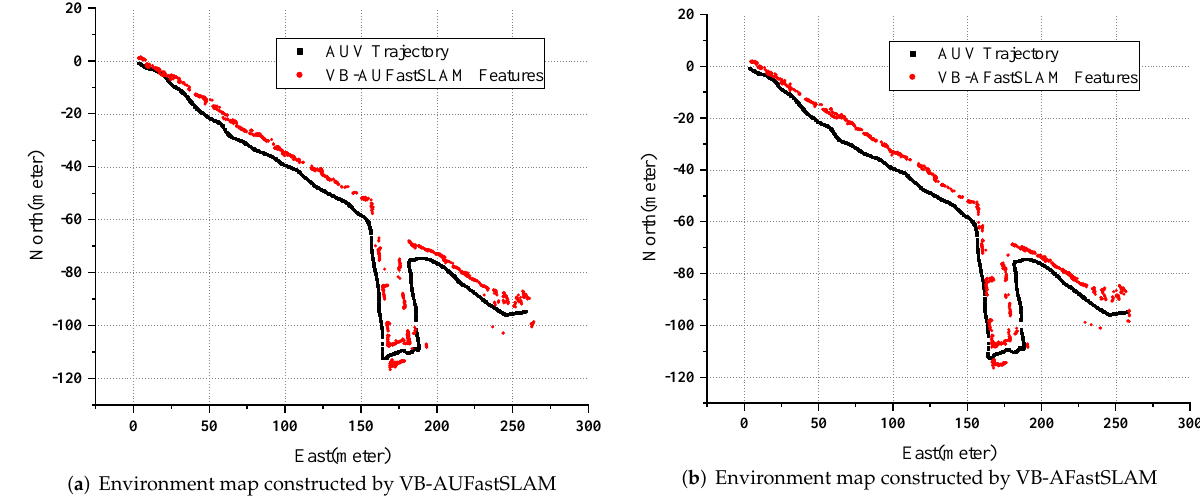
Figure 10. The results of the proposed two algorithms for building the